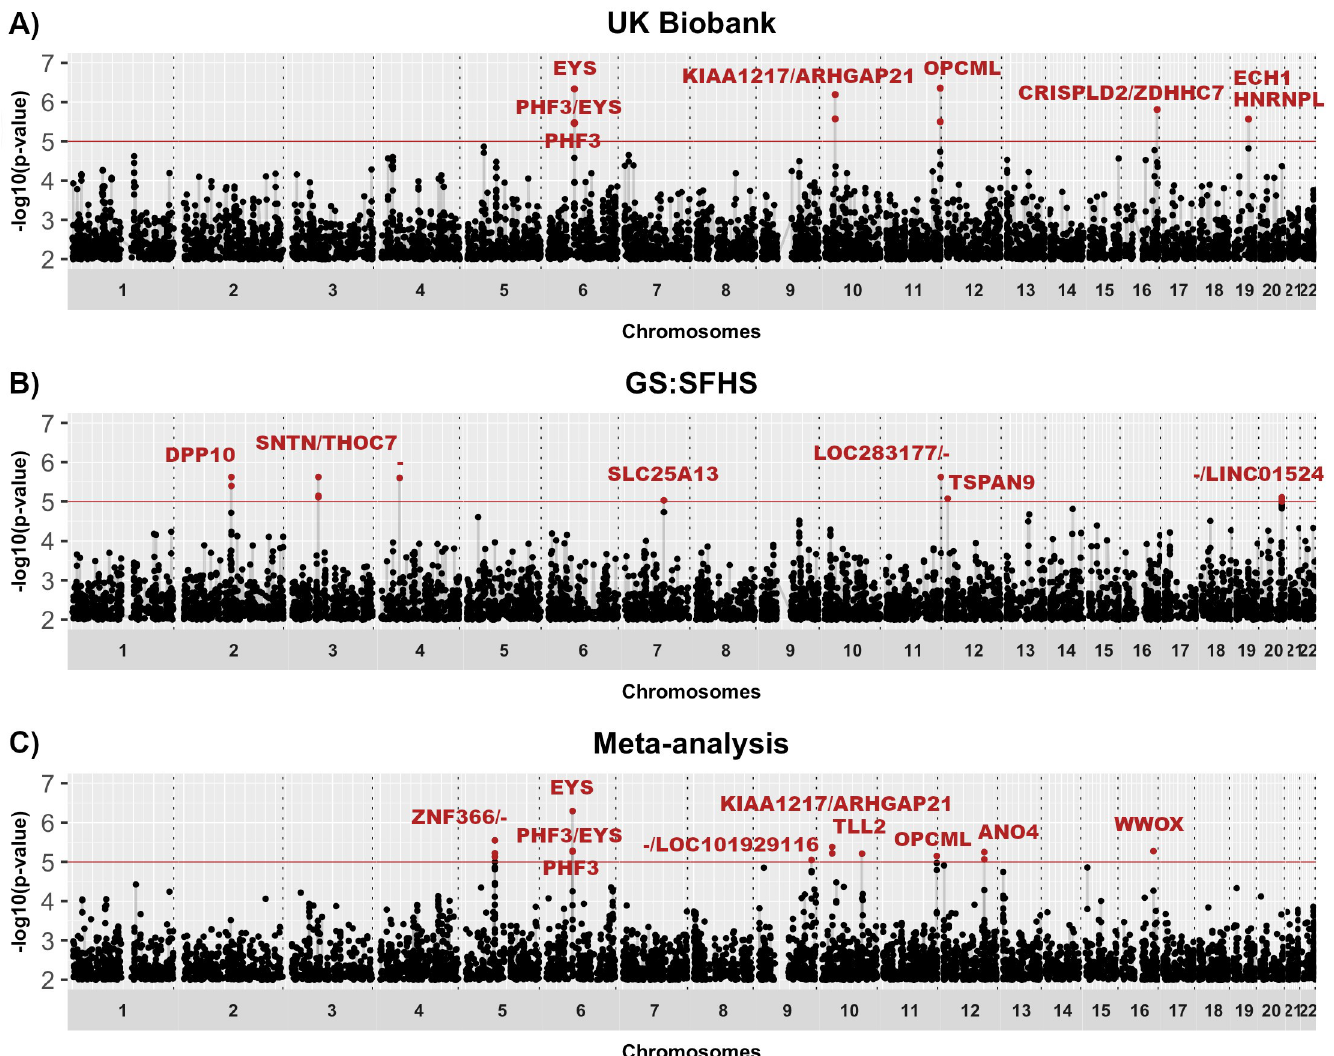
Fig 1. Manhattan plots showing stress-sensitivity associations. Manhattan plots of the GWIS from (A) UKB, (B) GS:SFHS and (C) sample size weighted meta- analysis of UKB and GS:SFHS. The x-axis is chromosomal position and y-axis is the p value (-log10 p value) of association with stress-sensitivity effect. Suggestive genome-wide significance threshold ( p = 1x10 -5 ) is shown by solid line at y = 5. Genes or closest gene up- and down-stream from SNP position (/) are annotated. “-“: No gene within 100kb of the SNP.